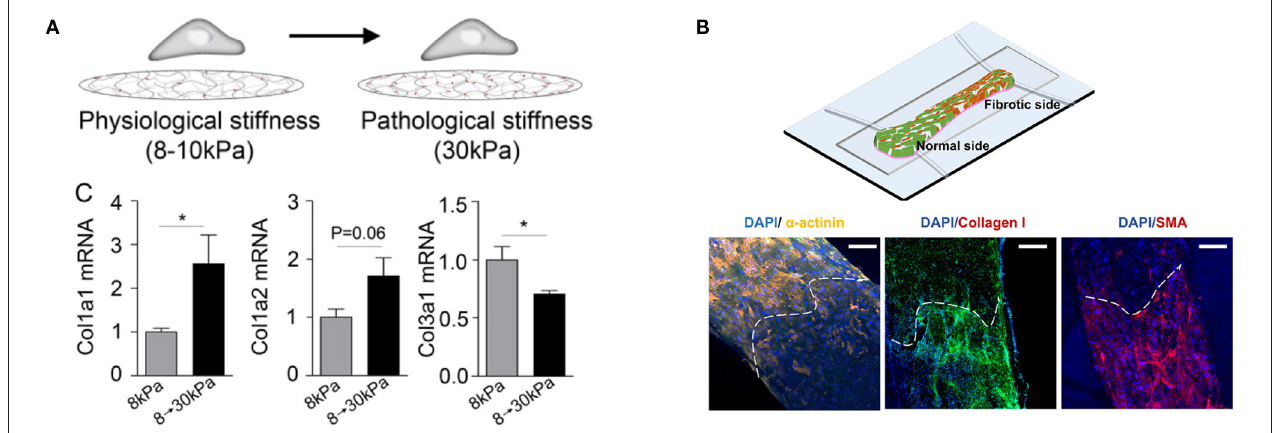
FIGURE 3 | Engineered in vitro fibrosis models that modulate stiffness in (A) time and (B) space. (A) A hyaluronic acid hydrogel is polymerized in situ upon exposure to UV light to mimic scar maturation after myocardial infarction. Stiffening from 8 to 30 kPa results in collagen turnover (* p < 0.05). Republished with permission of the American Society for Cell Biology, from Herum et al. (115); permission conveyed through Copyright Clearance Center, Inc. (B) A heteropolar biowire integrates normal (7.6 kPa) and fibrotic (61.1 kPa) cardiac tissue. The white dashed line indicates the interface between normal and fibrotic regions. Normal regions exhibit increased α -actinin, a component of sarcomeres in cardiac myocytes, while fibrotic regions have increased collagen and α -smooth muscle actin, indicating increased presence of myofibroblasts. Images reproduced with permission of the American Chemical Society, from https://pubs.acs.org/doi/full/10.1021/acscentsci.9b00052 (136). Further permissions related to the material excerpted should be directed to the American Chemical